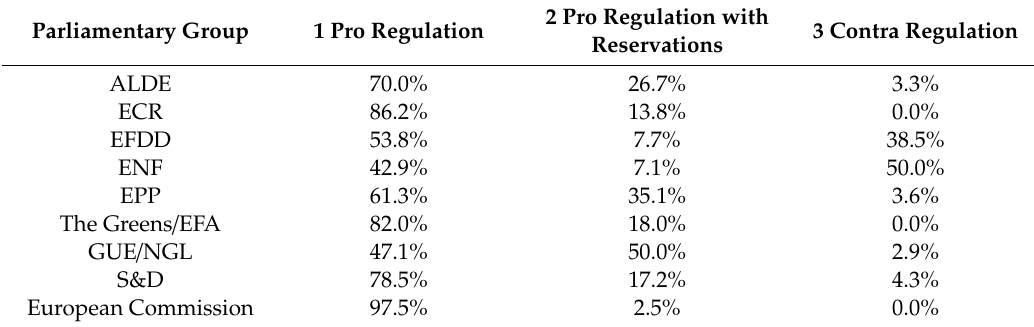
Table 2. Category frequencies per parliamentary group of the European parliament and for the European Commission.